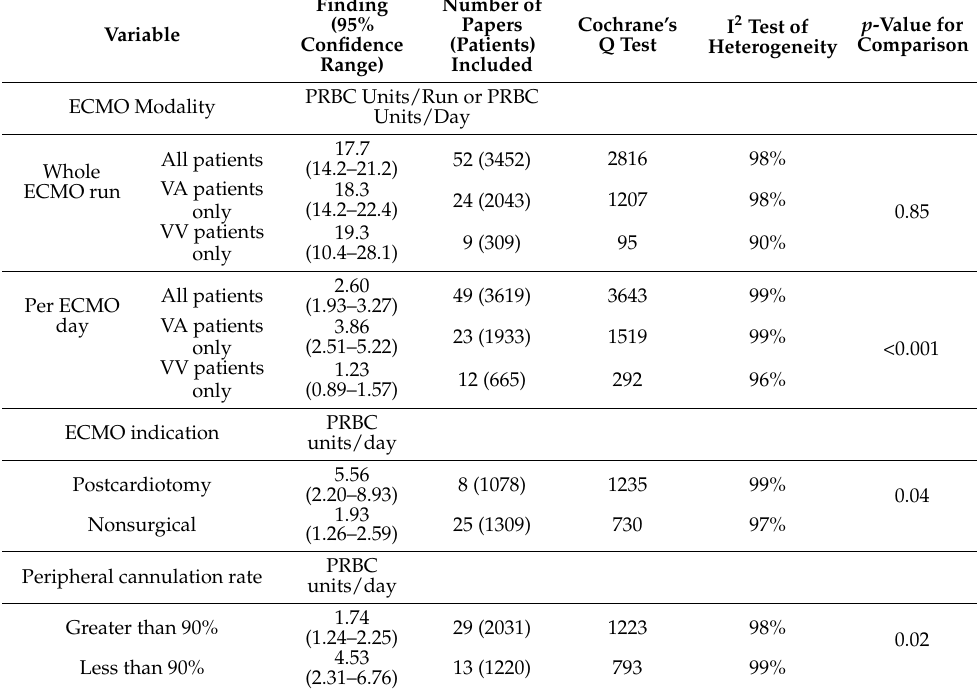
Table 3. Results—red cell transfusion